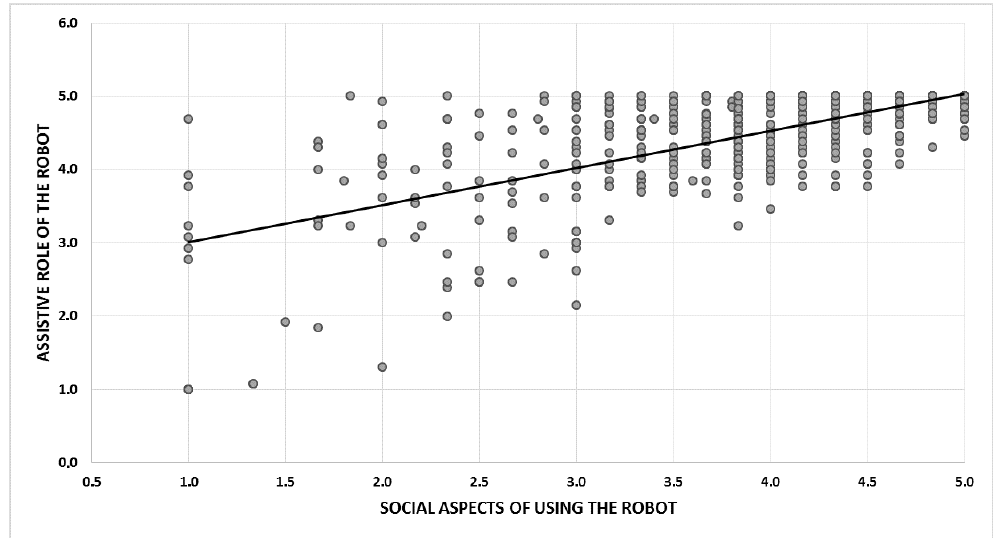
Figure 1. Relationship between the assessment of social and assistive functions in 720 people.